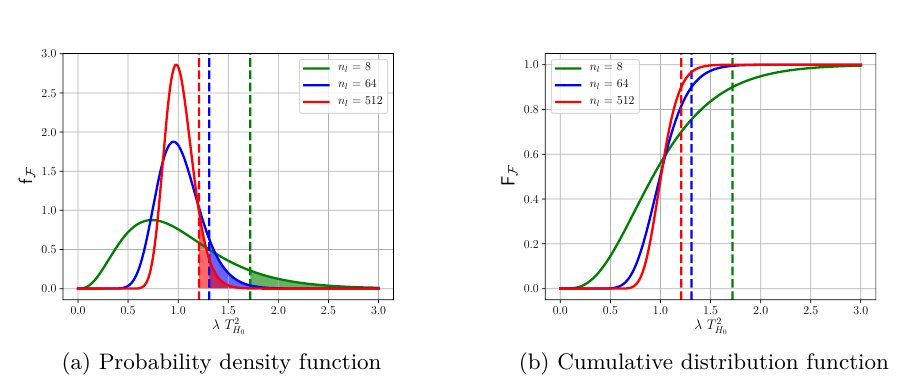
Figure 3: The PDF and CDF of different Fisher distributions with varying n l and their corresponding threshold th T 2 (dashed lines) for α = 0 . 1 and N X = N Y = α